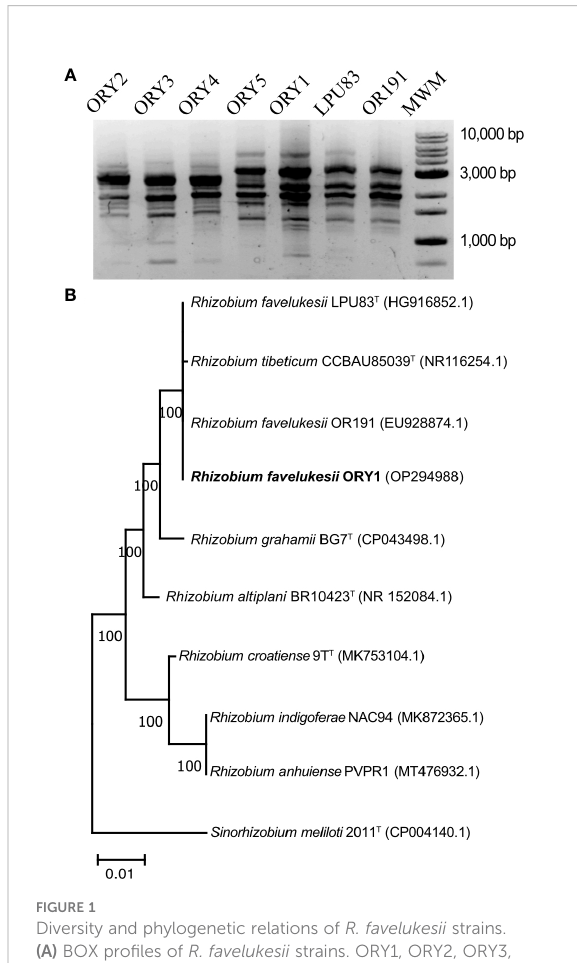
FIGURE 1 Diversity and phylogenetic relations of R. favelukesii strains. (A) BOX pro fi les of R. favelukesii strains. ORY1, ORY2, ORY3, ORY4 and ORY5 strains were collected in Uruguayan acids soils and the reference strains LUP83 and Or191 from acid Argentinan and USA soils respectively. MWM (Molecular weight marker). (B) Phylogenetic tree inferred using Maximum likelihood method based on partial sequences alignments of 16S rRNA genes (1.342nt). With bold letters is indicated the strain isolated from Uruguayan soil. The genome of the other strains was obtained from the NCBI. Asterisk (*) indicates the Type strain. Bootstrap values calculated for 1000 replications are indicated. Bar, 1 nt substitution per 100